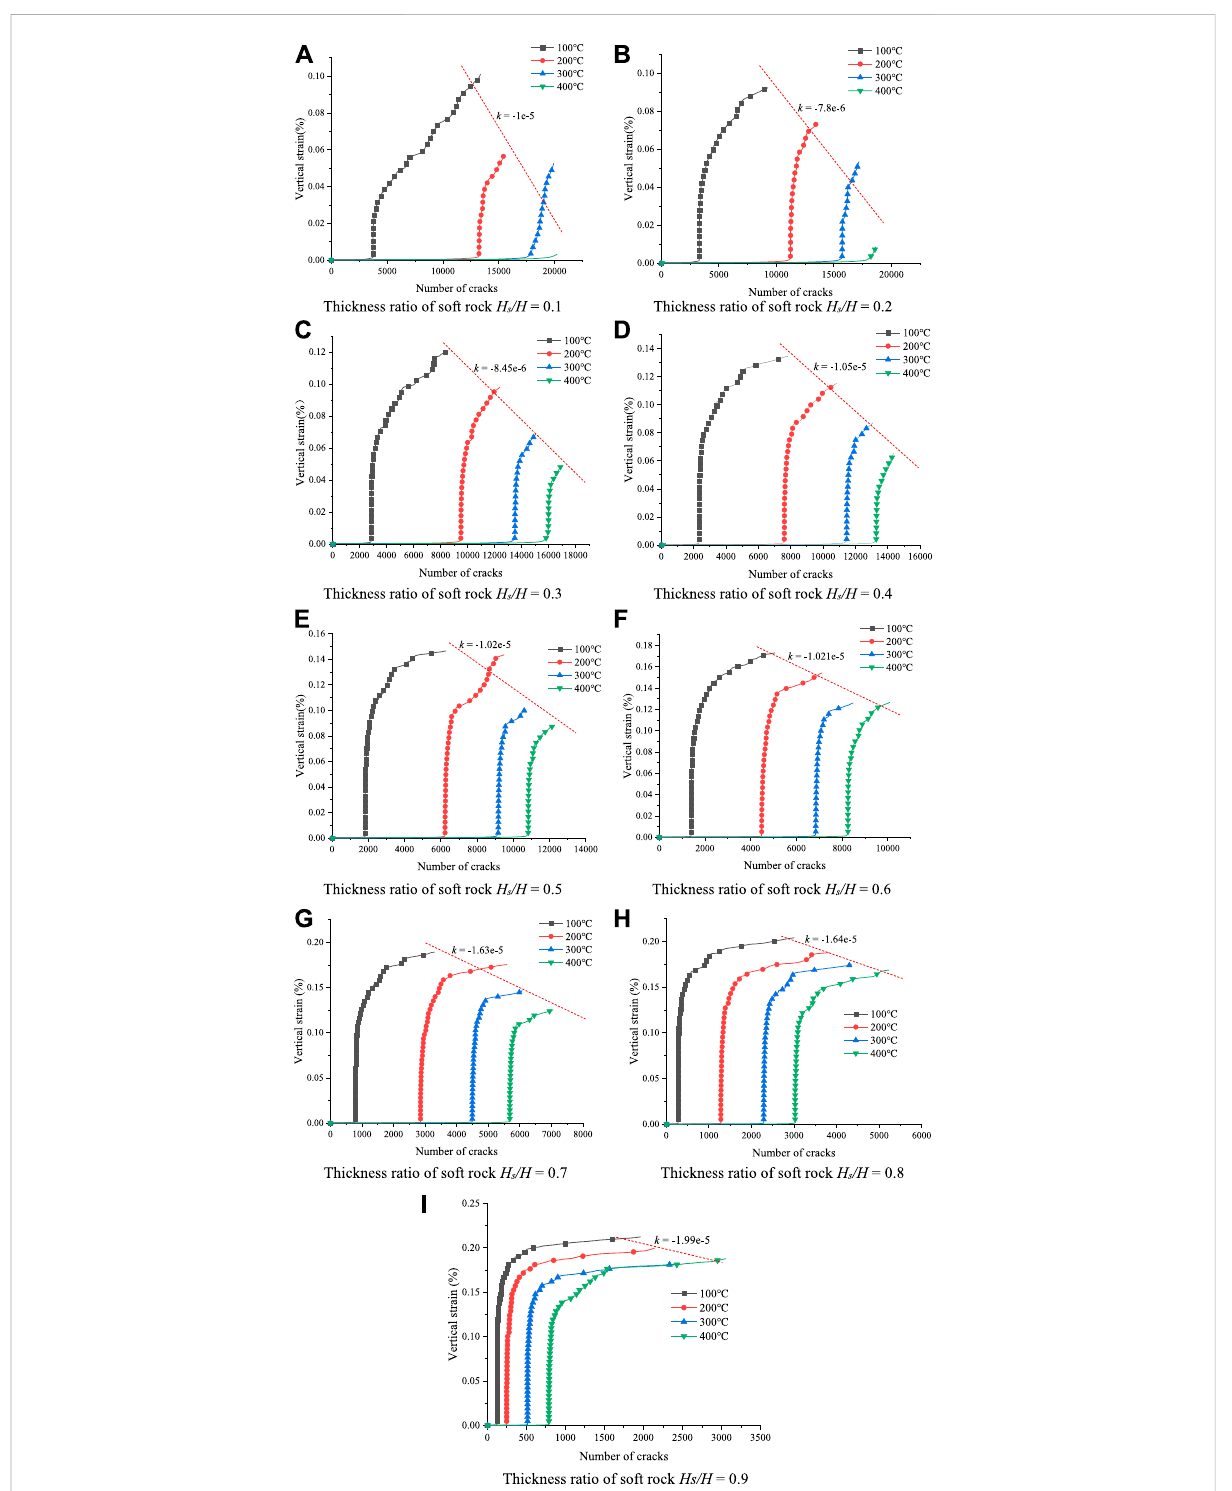
FIGURE 10 Relationship curve between vertical strain and crack number under different thickness ratios of soft